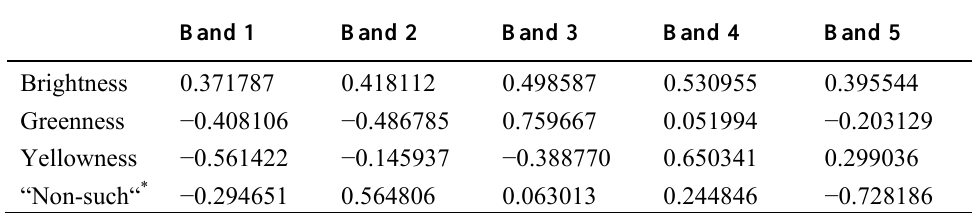
Table 2. Coefficients for the calculation of the tasselled cap indices derived from atmospherically corrected ASTER data over Khorezm, Uzbekistan.